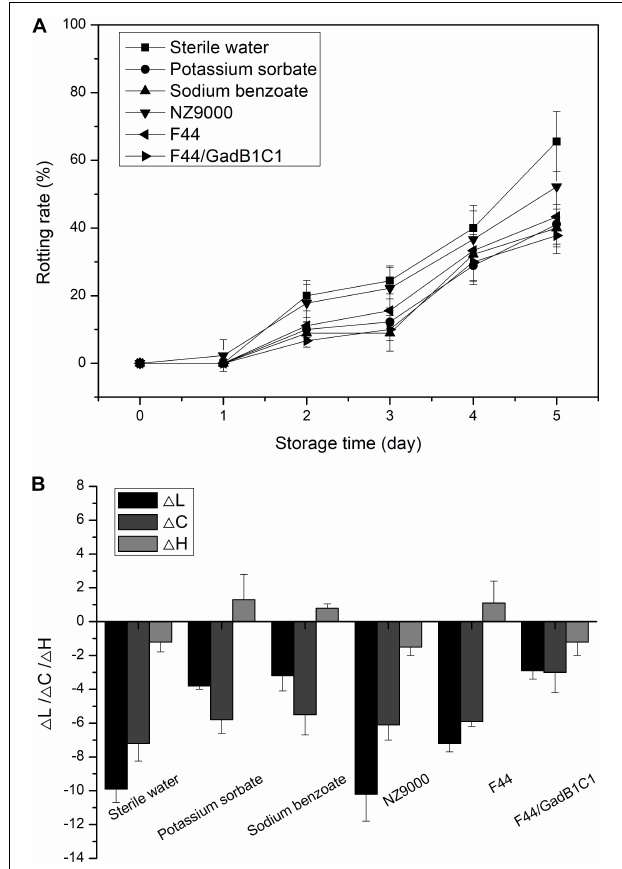
FIGURE 6 | Effect of different treatments on rotting rate (A) and color change ( (cid:49) L , (cid:49) C , and (cid:49) H ) (B) of strawberry during storage at room